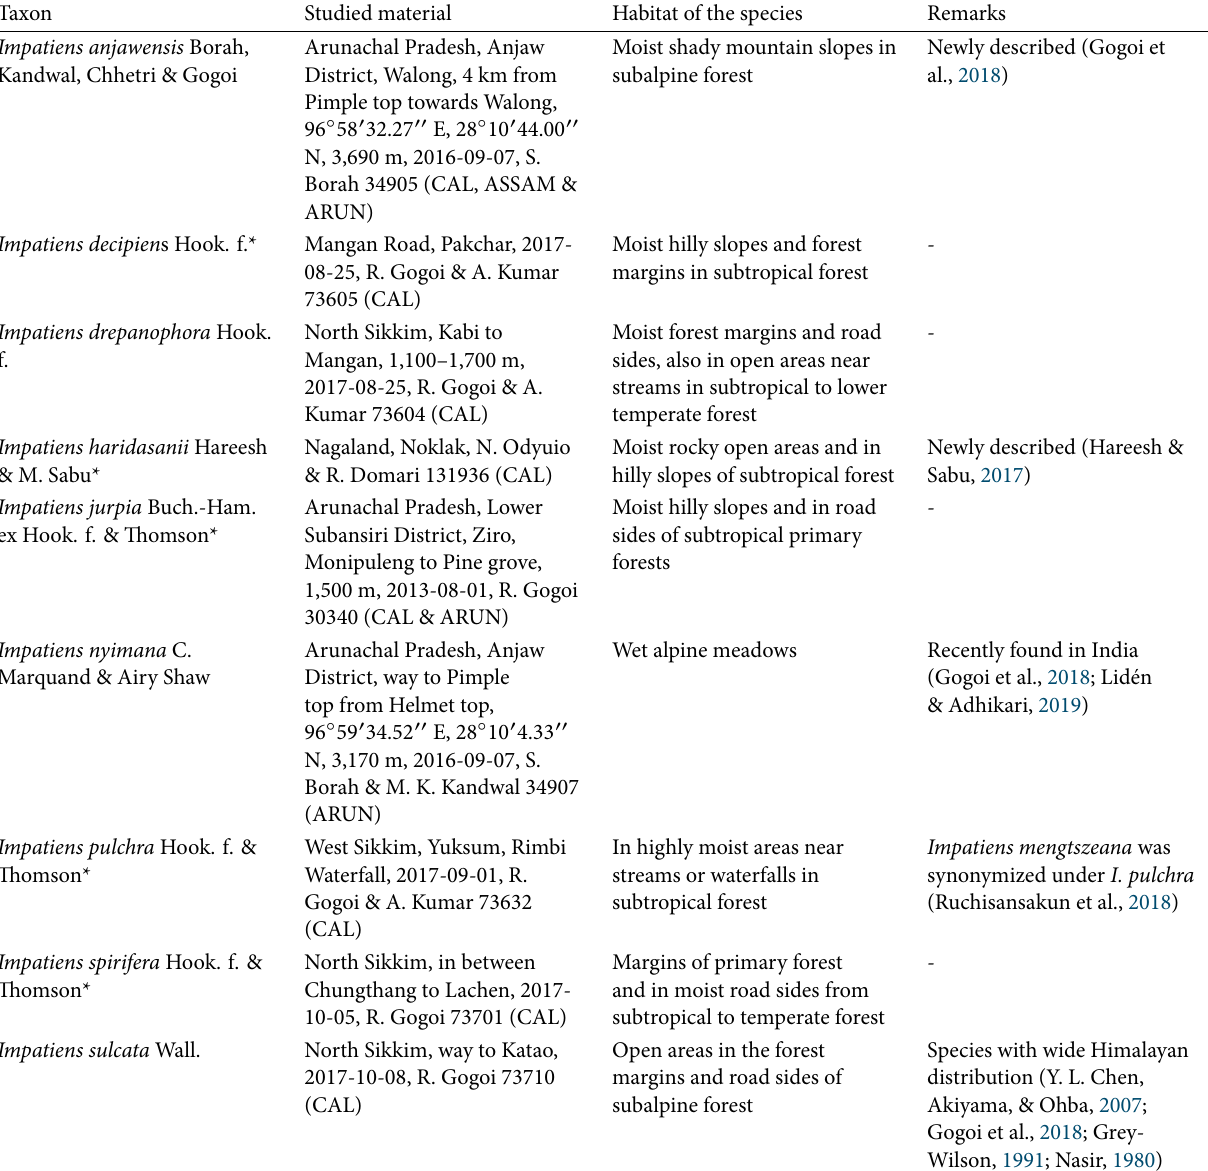
Table 1 Studied Impatiens species.